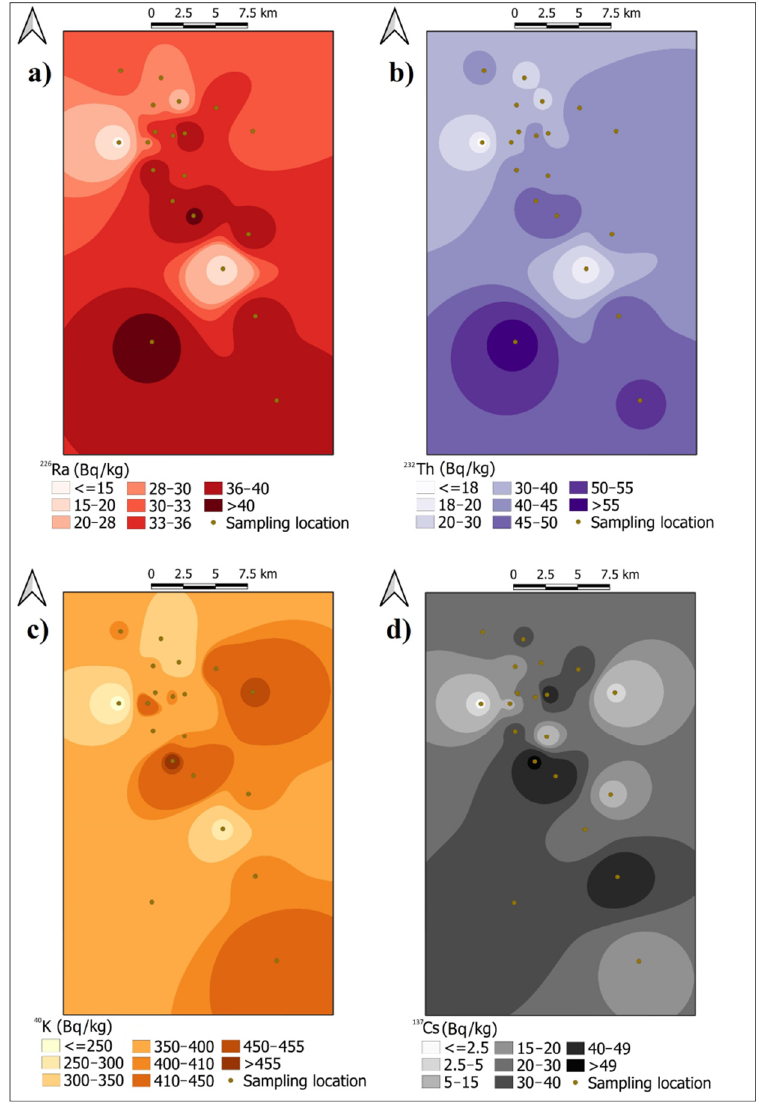
Figure 2. The spatial distribution of ( a ) 226 Ra, ( b ) 232 Th, ( c ) 40 K, and ( d ) 137 Cs in soil. Table 2. Specific activities of 40 K, 7 Be, and 137 Cs in leaves, annual effective dose, and excess lifetime cancer risk from natural radionuclides in soil. MDA—minimum detectable